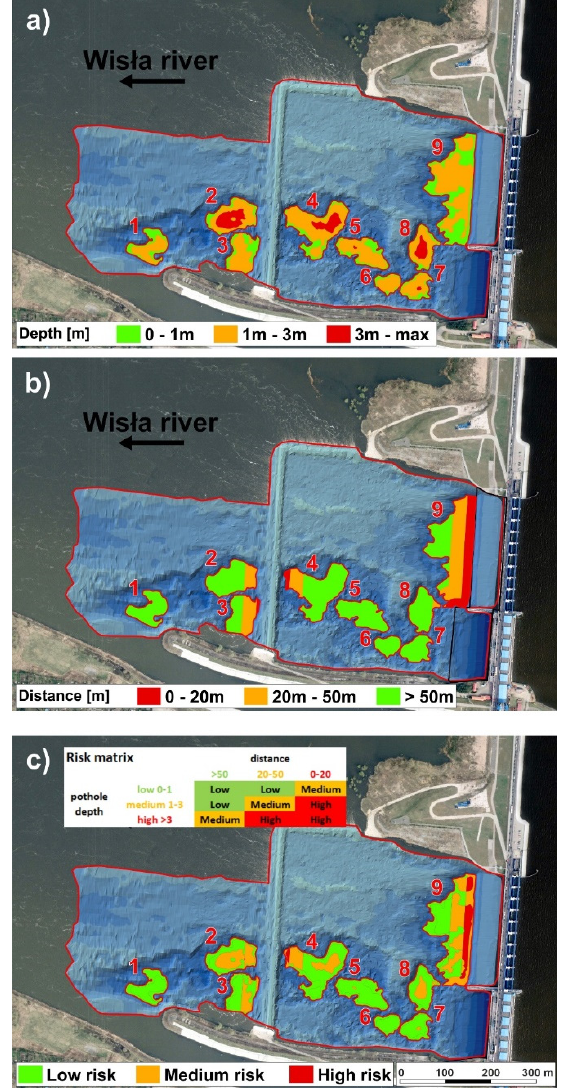
Figure 10. River bottom hazard map ( a ) classification by factor of pothole depth, ( b ) classification by factor of distance from structure of dam and threshold, ( c ) final map classification by combination of these 2 factors (methodology is in risk matrix).